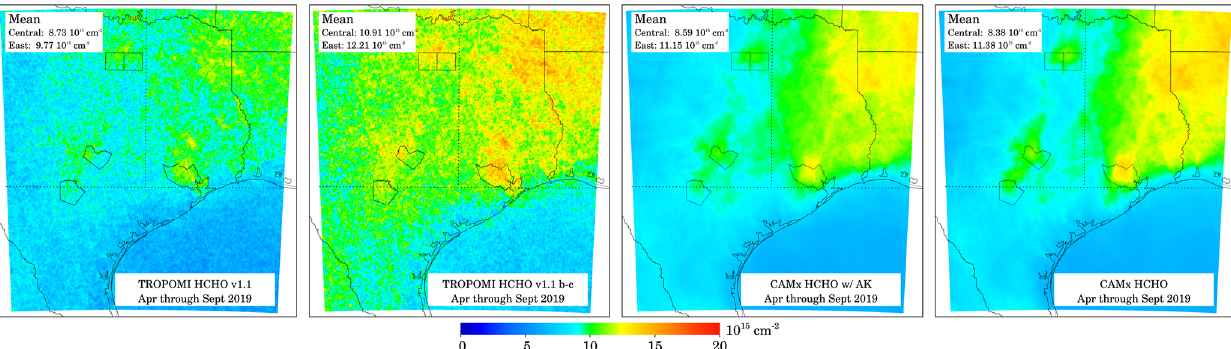
Figure 10. HCHO tropospheric vertical column amounts averaged across April through September 2019 from (a) TROPOMI, (b) the TROPOMI bias-corrected model, (c) the CAMx regional model with the TROPOMI averaging kernel (AK) applied, and (d) CAMx without the AK applied. All model information is shown at the coincident TROPOMI overpass time ( ∼ 19:00UTC). Areas with invalid TROPOMI data are similarly screened out from the model out on a daily basis. The eastern and central Texas areas are denoted by the dashed